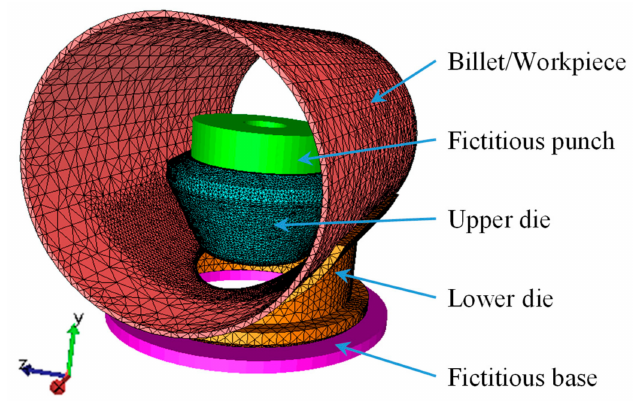
Figure 7. FE model of flanging